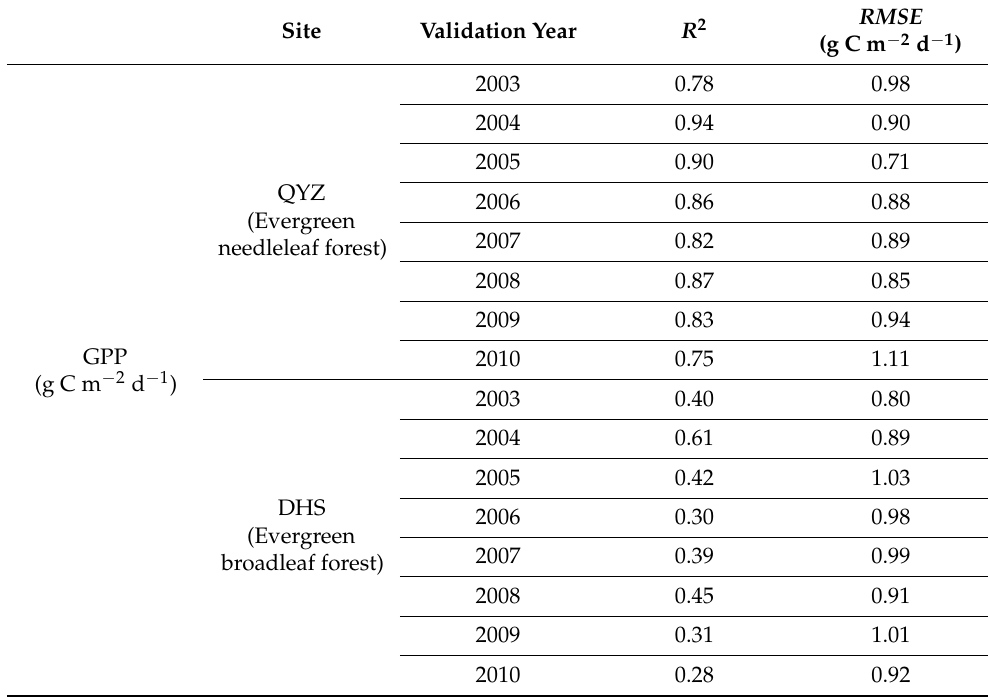
Table 2. Accuracy assessment of the model-estimated GPP relying on time-series SIF data at the two subtropical forest flux sites through leave-one-out cross-validation method.